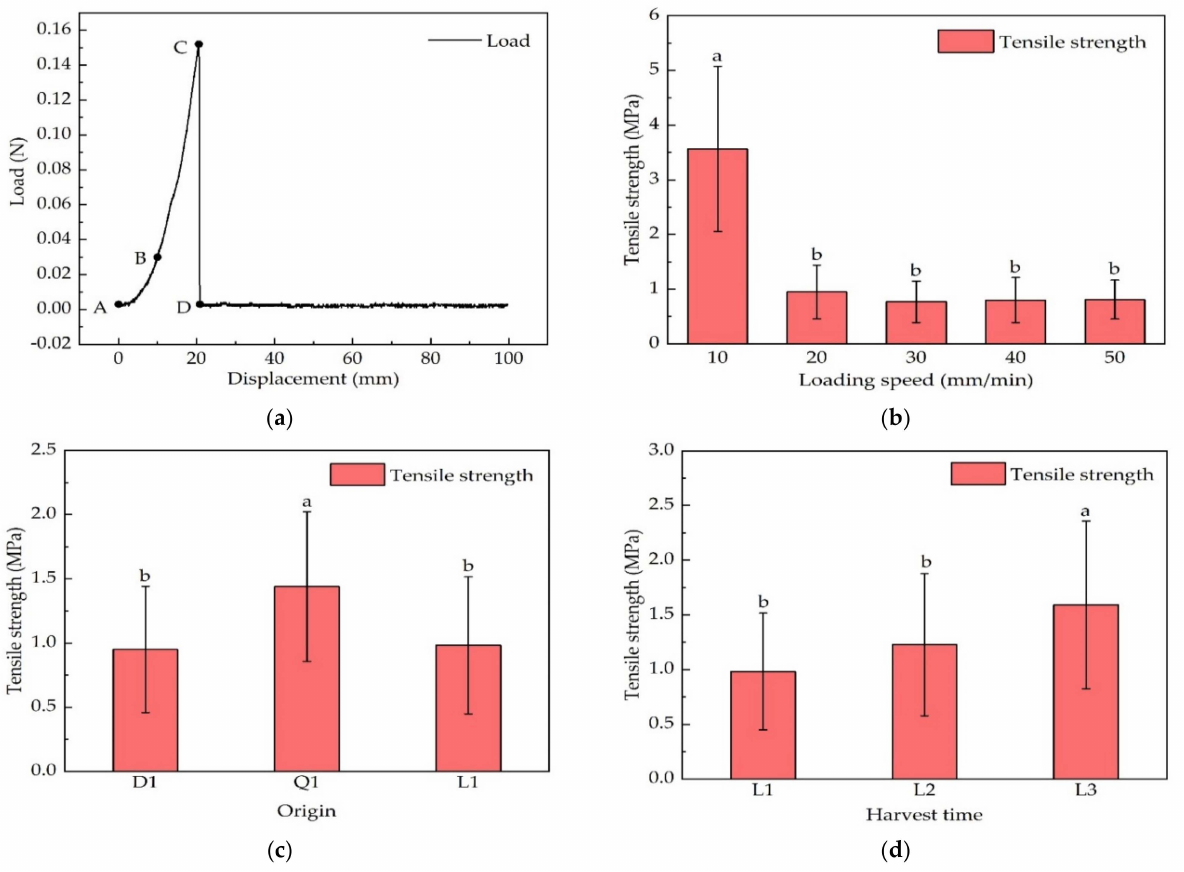
Figure 7. Tensile properties of laver: ( a ) the load–displacement curve of the tensile test of laver; ( b ) the effect of loading rate on tensile strength; ( c ) the effect of origin on tensile strength; ( d ) the effect of harvest time on tensile strength. The different lowercase letters indicate a significant difference between groups ( p < 0.05), while same lowercase letters indicate no significant difference between groups ( p >